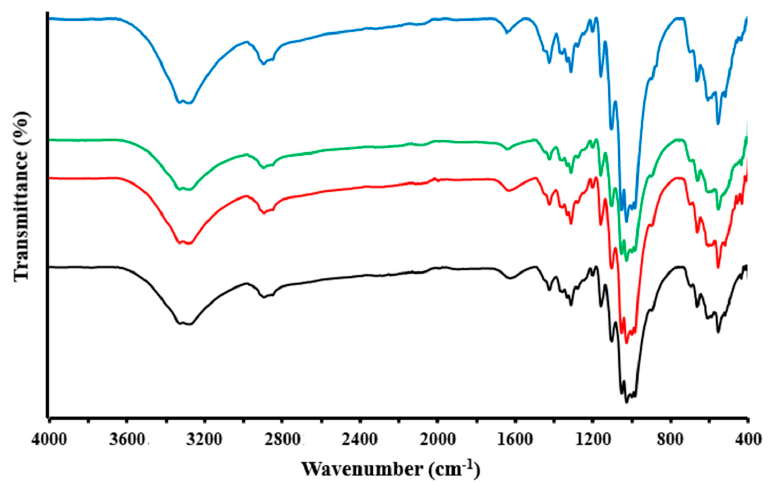
Figure 1. FTIR spectra of cotton − OH (black), cotton − OH − Ag (red), cotton − (PO(OH) 2 )(Cl) (green), and cotton − (PO(OH) 2 )(Cl) − Ag (blue). Cotton fiber is usually characterized by several absorption bands. In the spectrum of the cotton-OH sample, a large absorption band at 3600–3000 cm − 1 can be attributed to the free OH stretching vibration, as well as to intra- and intermolecular hydrogen bonds as- sociated with the chemical structure of cellulose [23]. Near this region, in the range 3000– 2800 cm − 1 , there are several narrow bands related to the stretching vibrations of the meth- ylene and methine groups. Usually, in this region, a single absorption band can be ob- served for samples consisting only of cellulose [24–26]. The appearance of multiple ab- sorption bands in this area in the original (initial) cotton is explained by the presence of pectin and waxes in its structure (pectin: 0.7–1.2%, waxes: 0.4–1.2%) [23]. The width of the band observed in the range of 1700–1500 cm –1 is because of not only the bending vibrations of H–OH bonds caused by the presence of adsorbed water [24] but also the peaks associ- ated with asymmetric stretching vibrations of carboxyl groups in pectin acid and pectate [27,28]. The shoulder in the region of 1453–1440 cm − 1 is associated with the presence of an absorption band of stretching of the O-CH 3 bond (1445 cm − 1 ) of pectin ester [27,28]. In the range of 600–1450 cm − 1 , specific and common bands appear, which are assigned to cellulose. The band at 1426 cm − 1 is related to the CH 2 bending of cellulose. The bands caused by the deformation of the OH groups of cellulose are located at 1334 and 1368 cm − 1 . The band at 1280 cm − 1 refers to the stretching of the C=O and G ring, and the bands at 1160 and 1202 cm − 1 refer to the symmetric and asymmetric stretching of the C-O-C bond. The bands from 1027 up to 1106 cm − 1 indicate the vibrations of C-O, C-C, and C-H bonds in